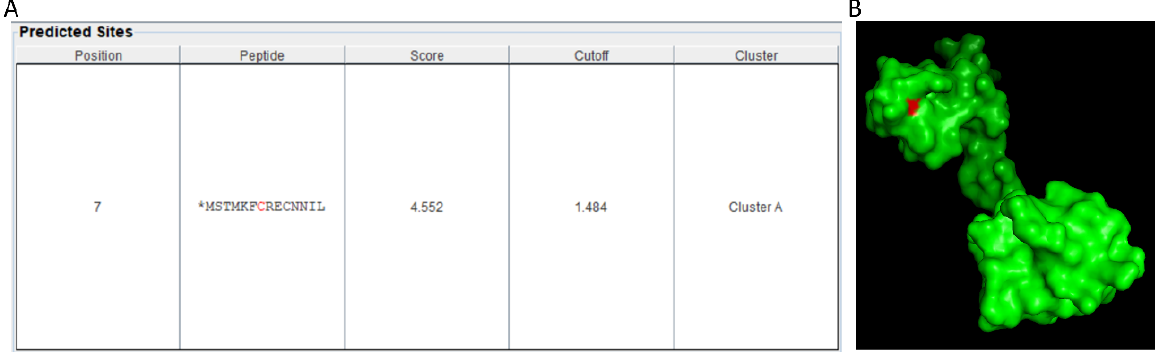
Figure 2. Prediction of possible S- nitrosation site in Rpb9 subunit of Pol II. ( A ) The peptide sequence of Rpb9 was analyzed using GPS SNO 1.0 with maximum threshold. Cys07 was predicted as site for S-nitrosation ( B ) The 3D structure of Rpb9 was retrieved from the uniport database and analyzed using PyMOL 2.4. The Cys07 was highlighted as red.